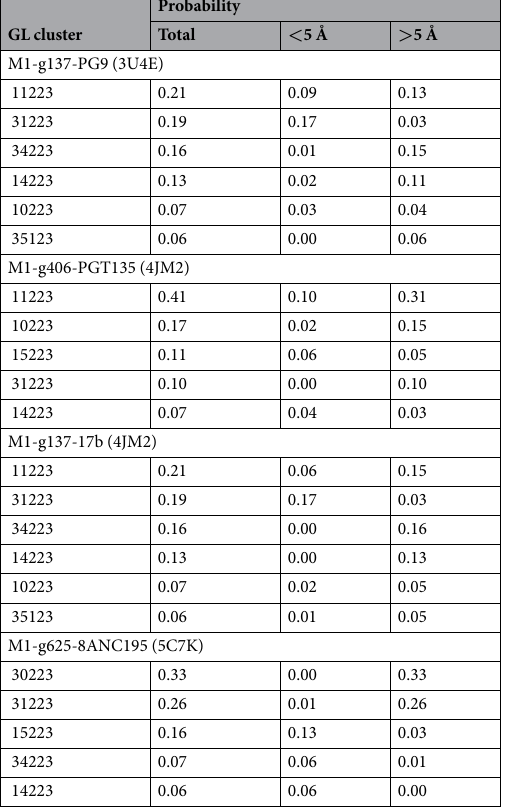
Table 4. Probability of sampling GL clusters based on the first 5 linkages for all model snapshots and those with the minimum distances > or < 5 Ang for selected glycans with the CDR regions of selected glycans. GL cluster Probability. Only GL clusters sampled at a probability of 0.05 or more for either < or > 5 Å are